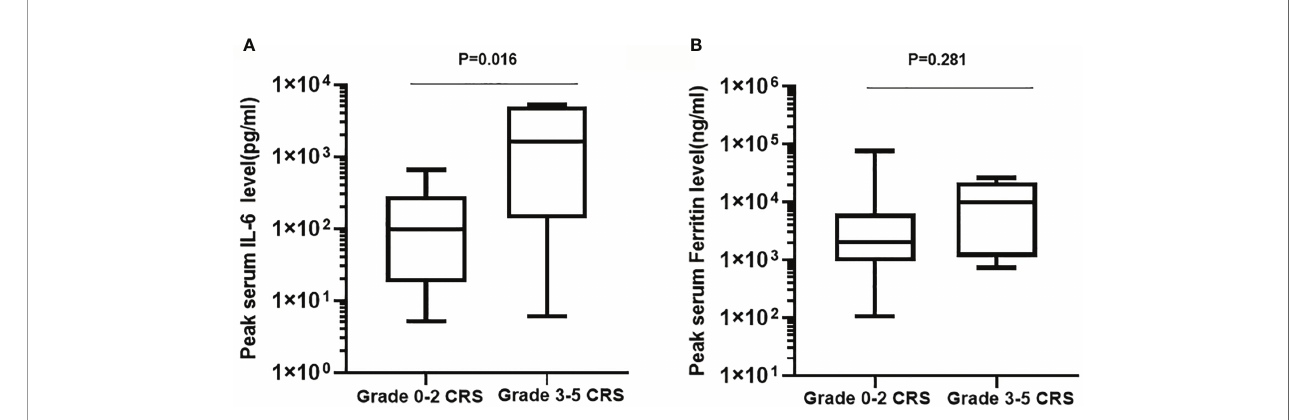
FIGURE 2 | Peak serum levels of IL-6 (A) and ferritin (B) in patients who developed grade 3-5 CRS (n=8) compared with those with grade 0-2